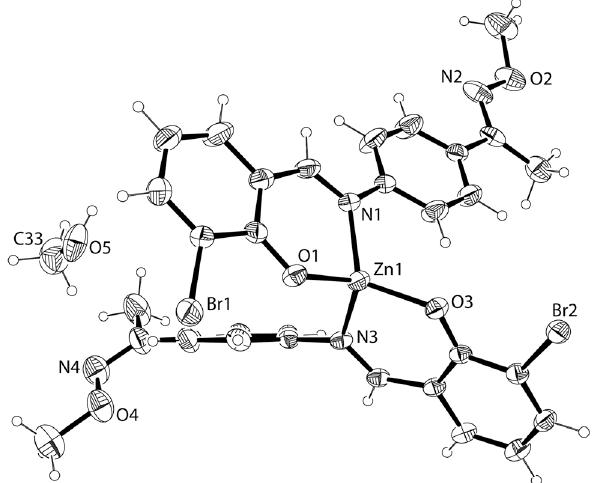
Table  : Data collection and